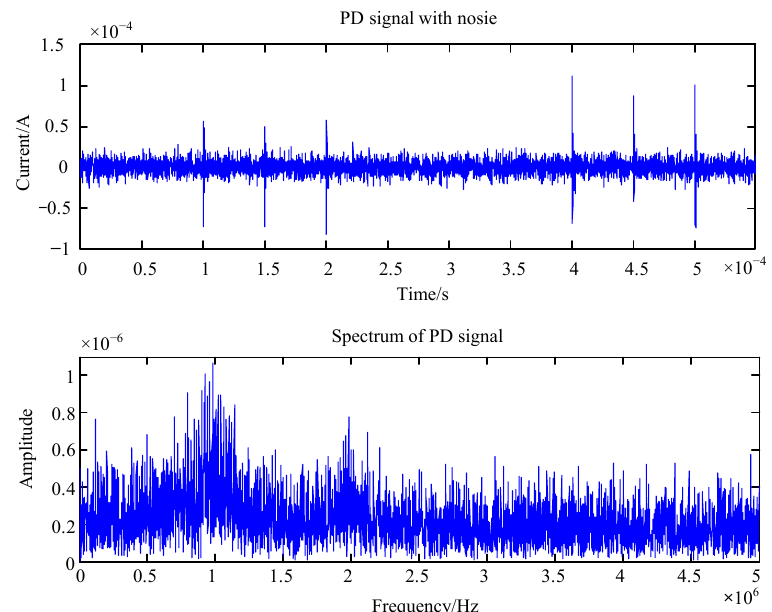
Figure 3. The waveform of the PD signal with noise and its spectrum.